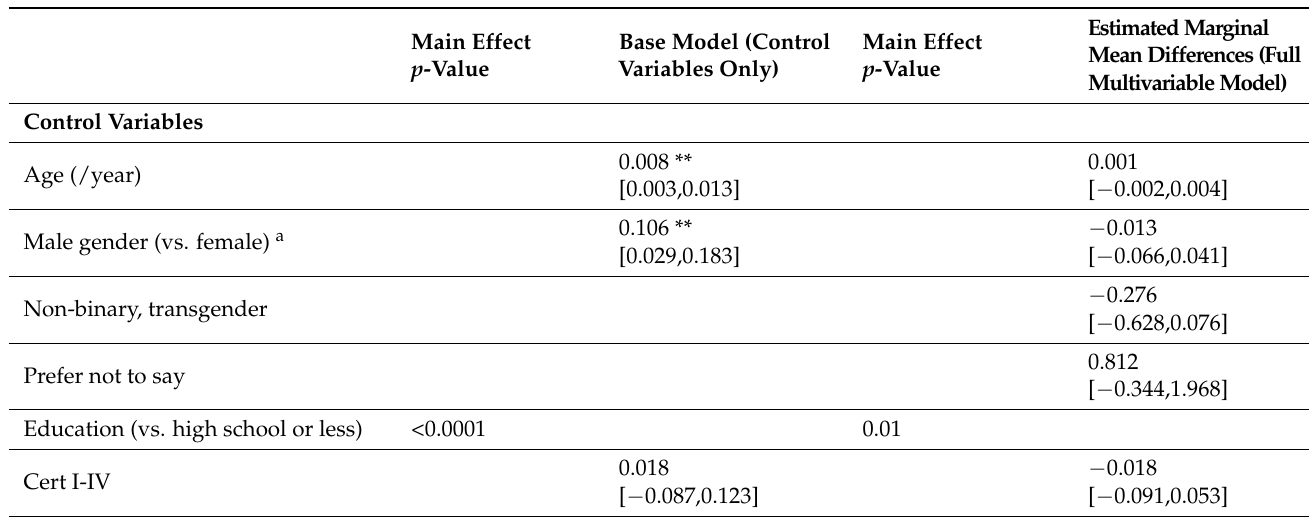
Table 8. Multivariable truncated linear regression of the misbeliefs score. Higher values of the outcome indicate greater support for misbeliefs. Data are presented as estimated marginal mean differences (95% CIs). Statistical significance is indicated by * p < 0.05; ** p < 0.01; *** p < 0.001. N = 2050 complete